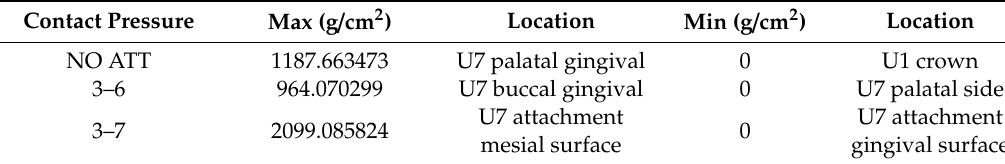
Table 3. Aligner / tooth contact pressure.